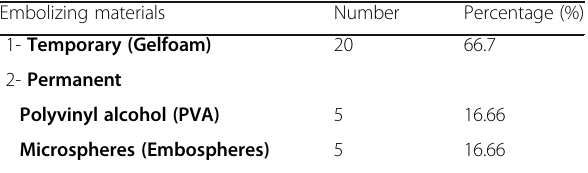
Table 9 Type of embolizing materials used in different patients Embolizing